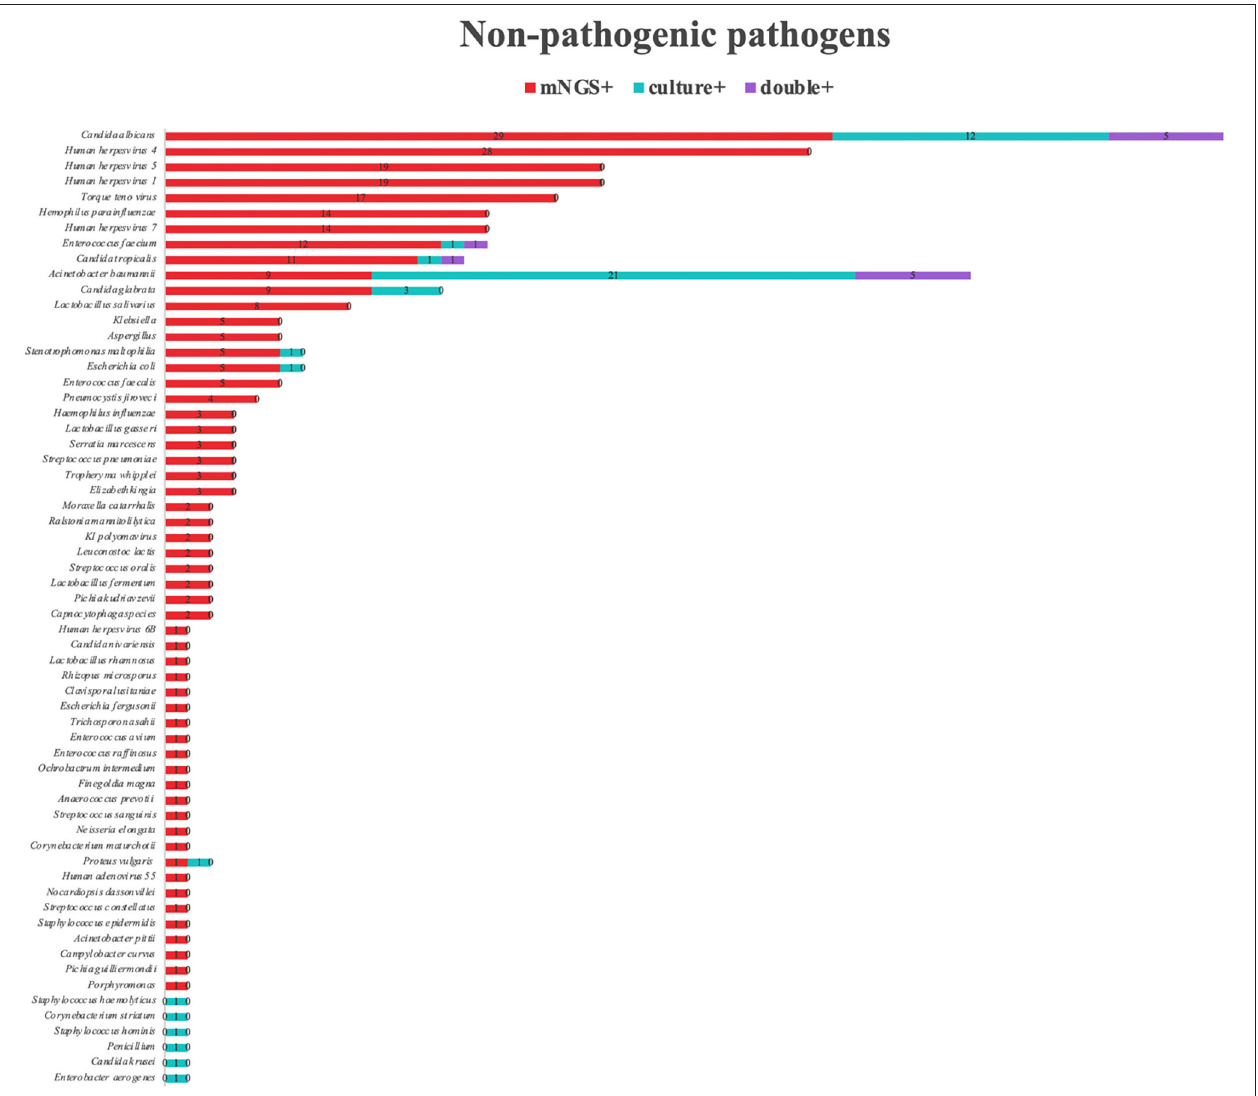
FIGURE 5 | Non-pathogenic pathogens detected by mNGS. A total of 64 different non-pathogenic pathogens were detected in the mNGS group. Human herpesvirus 5 , Candida albicans , Human herpesvirus 4 are the most common non-pathogenic pathogens detected by mNGS. Acinetobacter baumannii , Candida albicans , Candida glabrata are the most common non-pathogenic pathogens detected by sputum culture. mNGS, metagenomic next-generation sequencing.